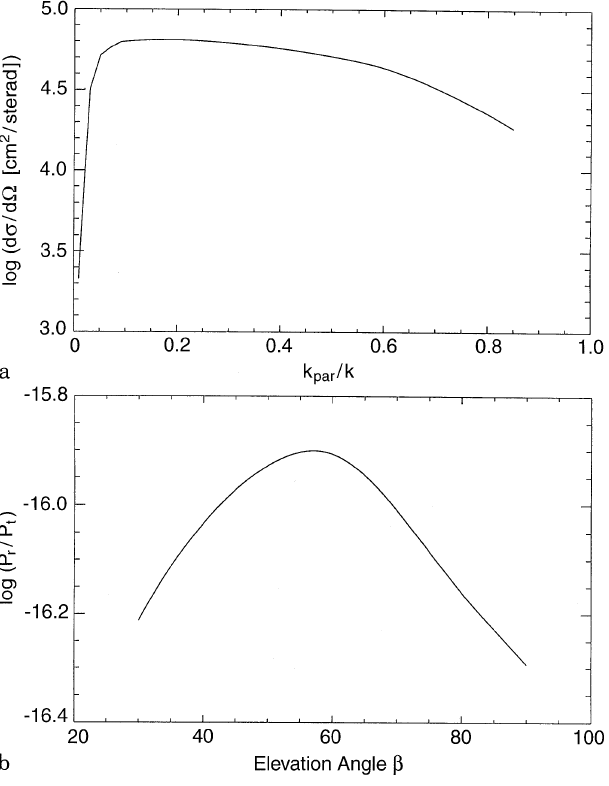
Fig. 4. a Cross-section per unit solid angle as a function of the aspect angle (cid:97) , expressed as the ratio k (cid:49)(cid:33)(cid:51) / k " sin (cid:97) for a radar frequency of 10 MHz. b Backscattered power ratio P (cid:114) / P (cid:116) as a func- tion of radar elevation angle for 10 MHz